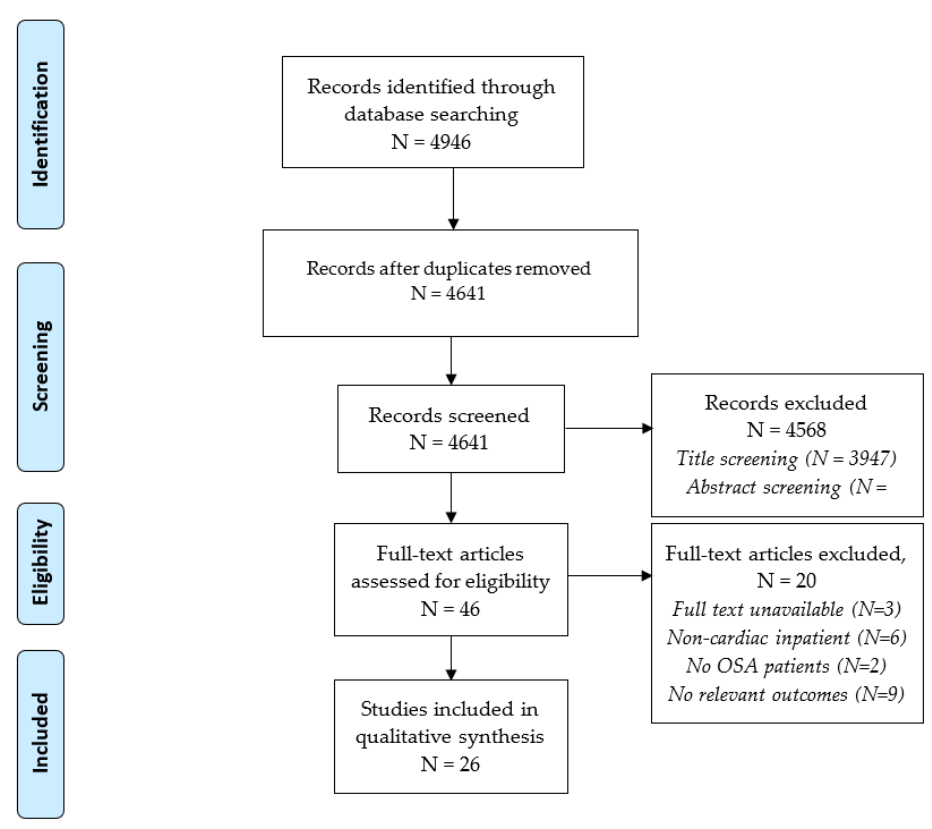
Figure 1. PRISMA study flow diagram.